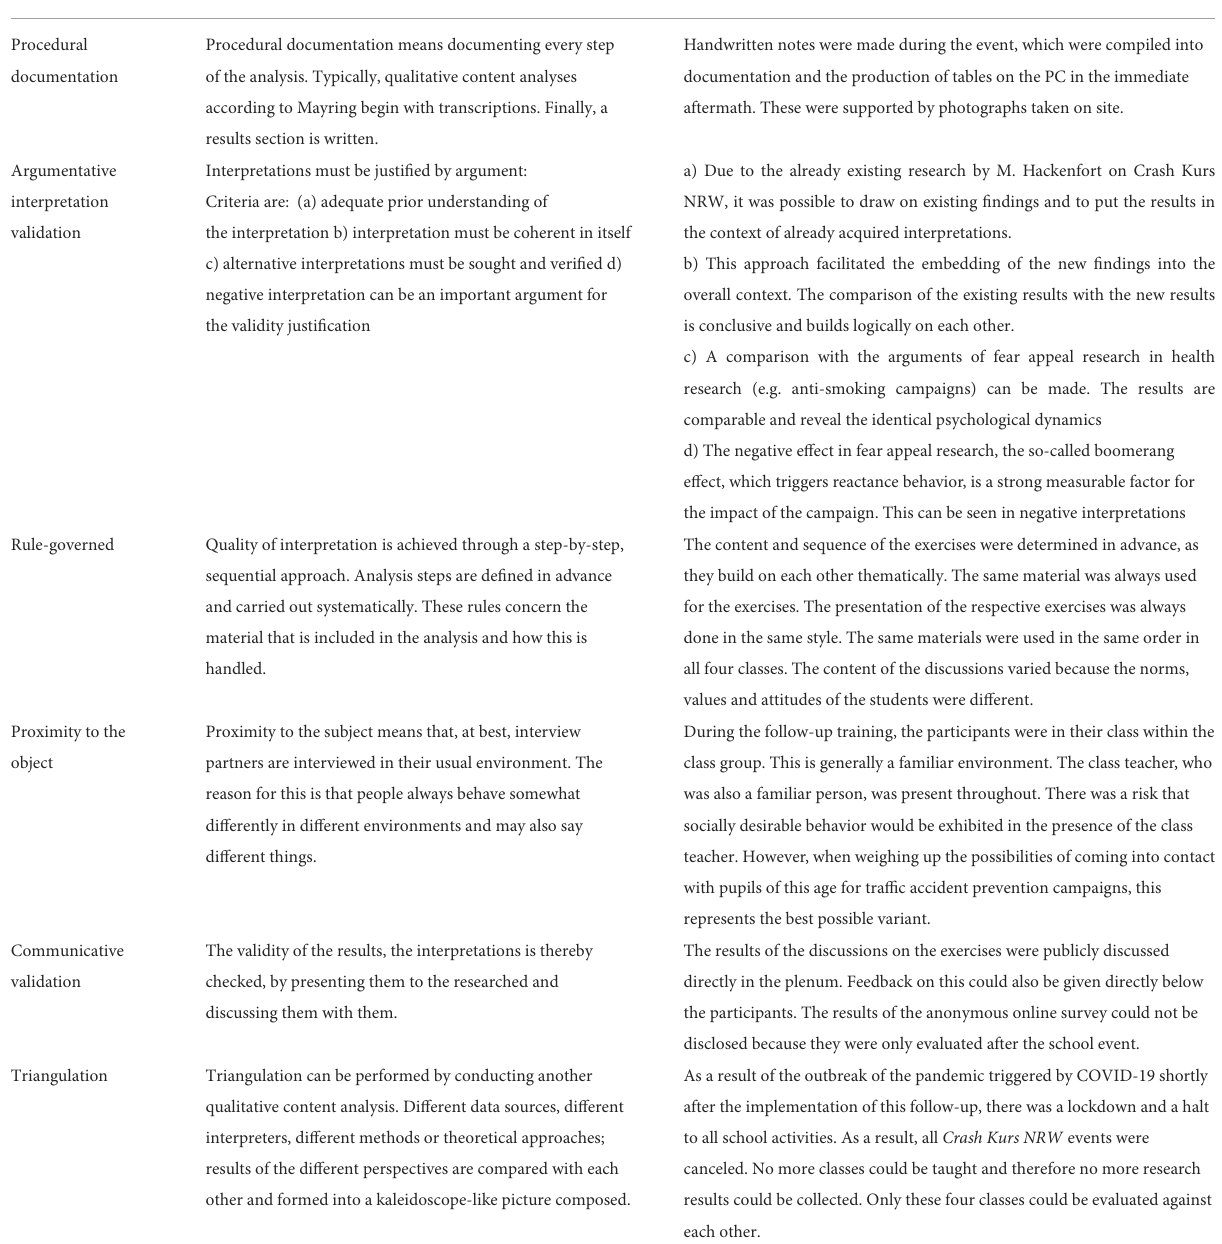
TABLE 5 Quality criteria of observational research according to Mayring, n =